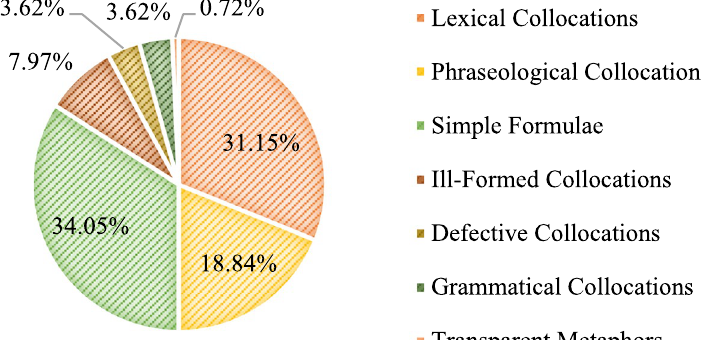
Fig. 5 Percentages of each phraseological unit type used in band scores 4–4.5